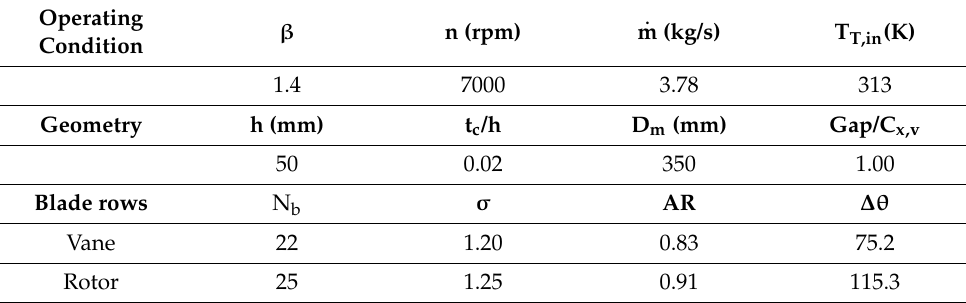
Figure 1. Turbine meridional view ( A ) and EWG layout ( B ). Table 1. Turbine geometry and operating